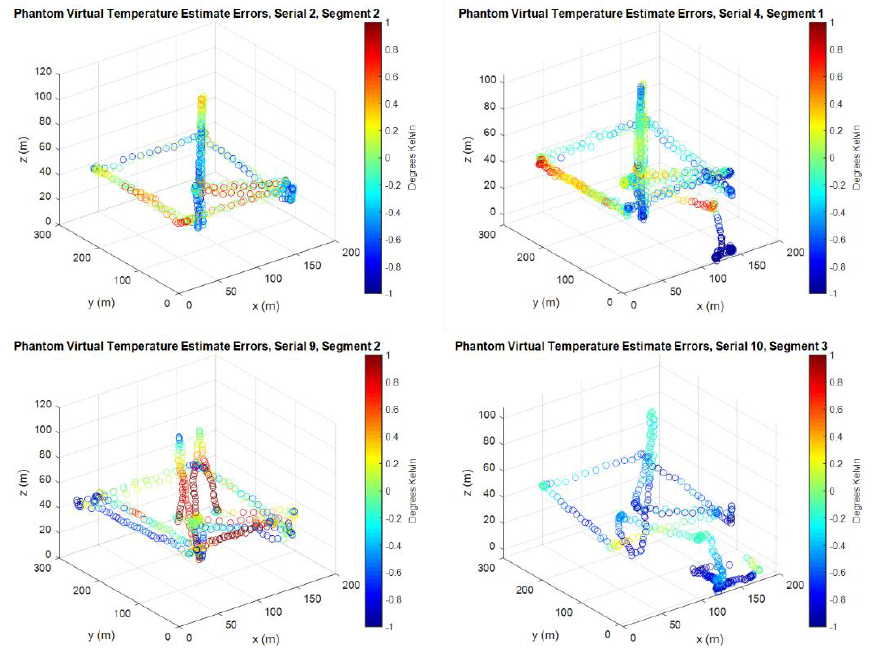
Figure 3: Comparison between UAV-based AAT temperature estimates and those observed independently by another